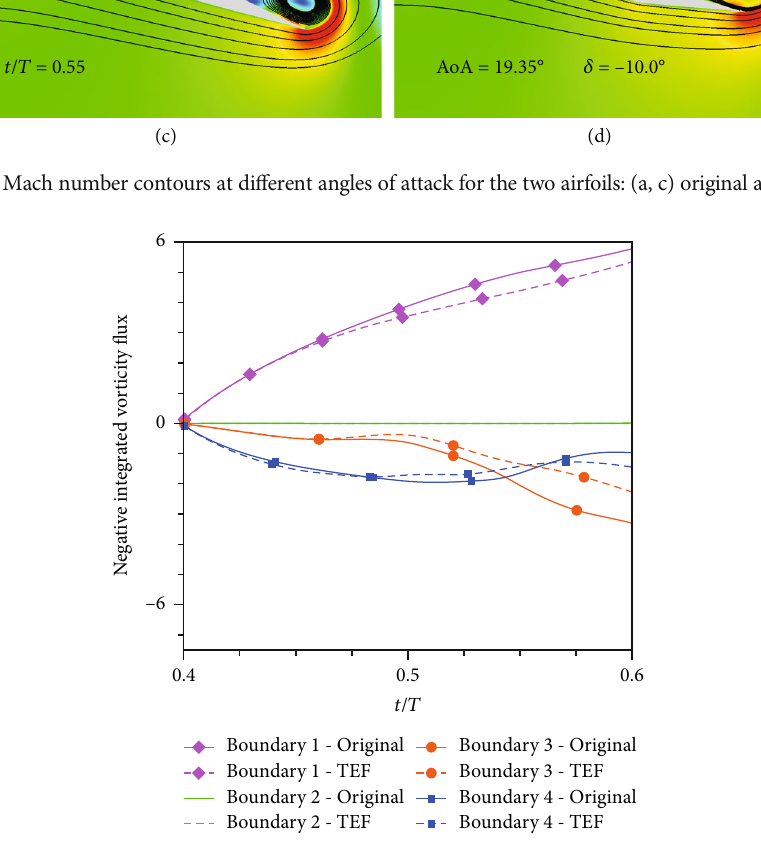
Figure 21: Comparison of the negative integrated vorticity fl uxes during the de fl ection duration of the TEF for the original and TEF